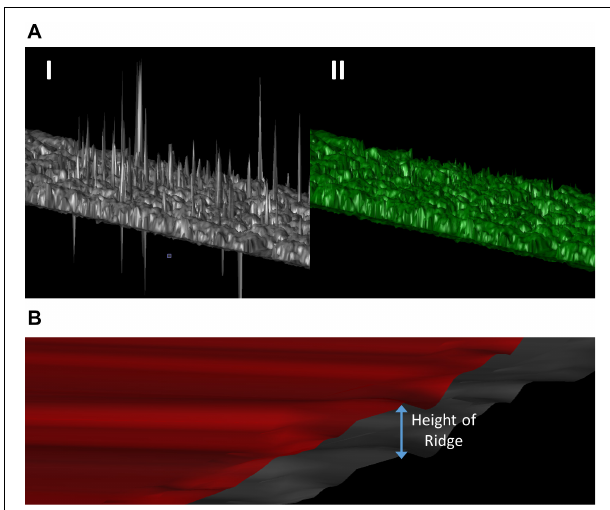
FIGURE 1 | (A) 3D representation of the point cloud before (I) and after (II) the manual removal of erroneous points. (B) Generation of a soil reference surface (red surface) by increasing every point of the topographical surface (gray surface) by the average height of all the ridges in the